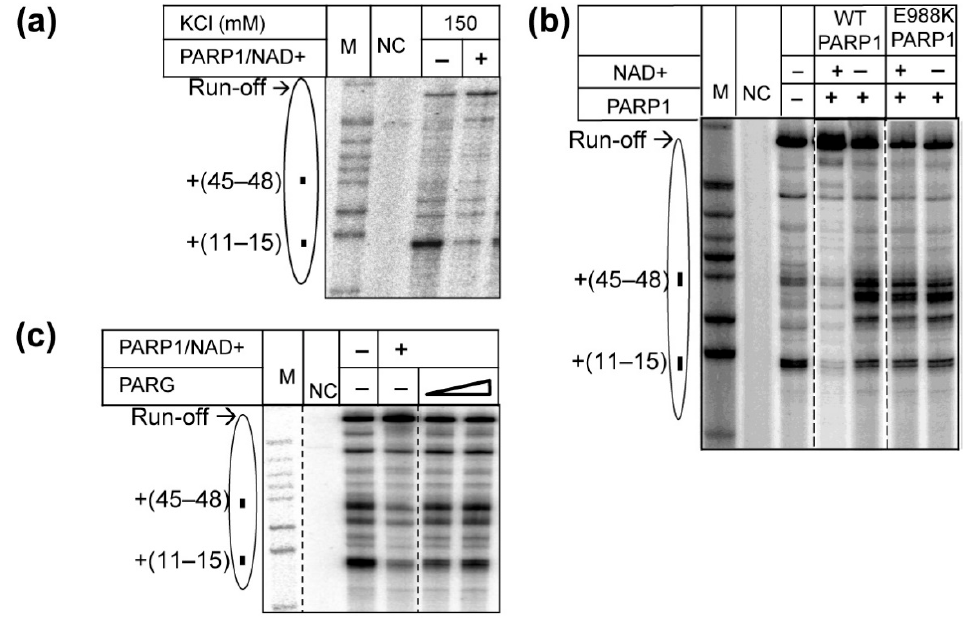
Figure 2. Catalytic activity of PARP1 is required to facilitate Pol II transcription through a nucleosome. ( a ) PARP1 facilitates transcription through the nucleosome by human Pol II. hPol II elongation complex was assembled and ligated to the 603. Transcription was conducted in the presence or in the absence of PARP1 and NAD+, as described in Figure 1a. ( b ) Catalytic activity of PARP1 is required to facilitate yPol II transcription through the nucleosome. Transcription through the nucleosome was conducted by yPol II as described in Figure 1a. ( c ) The effect of PARP1 on transcription through the nucleosome is compromised by PARP1 antagonist PARG. Analysis of pulse-labeled RNA by denaturing PAGE. Other designations are the same as in Figure 1.